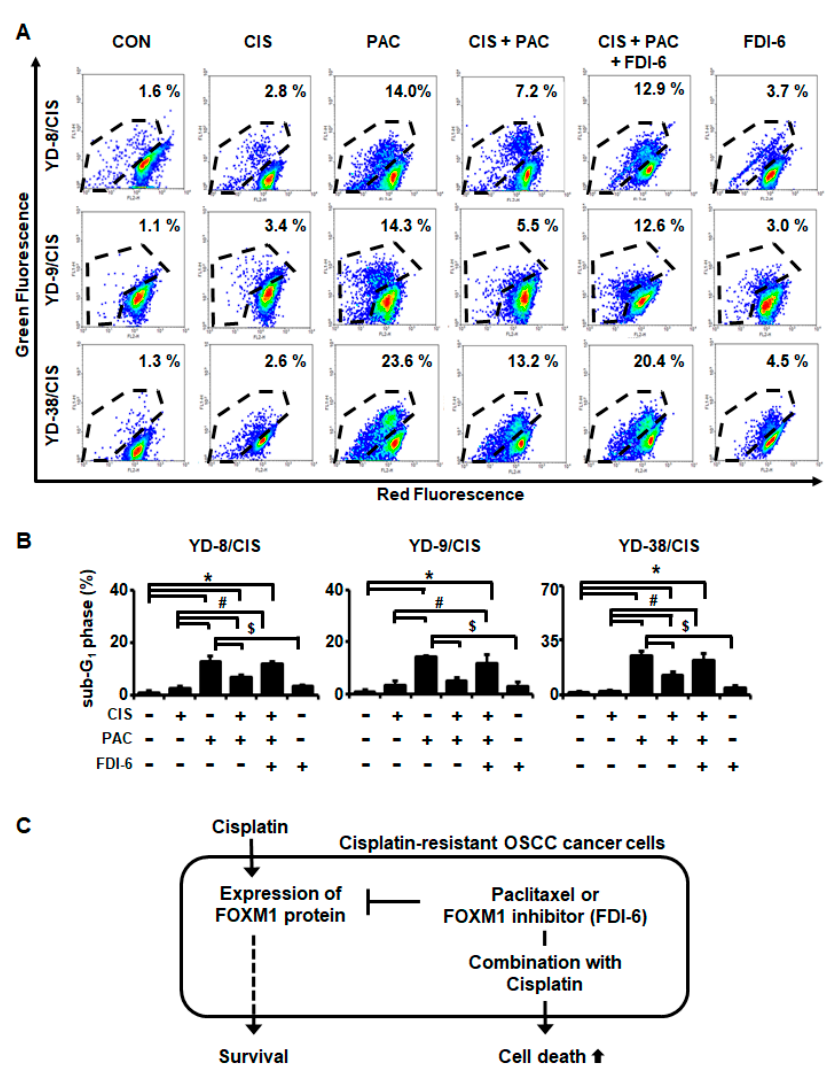
Figure 4. Treatment with FDI-6 in combination with cisplatin (10 µ g / mL) and paclitaxel (0.10 µ g / mL) for 24 h enhances apoptosis in cisplatin-resistant cell lines. ( A ) The fragmented DNA of apoptotic cells by each drug or combination treatment in cisplatin-resistant cell lines for 24 h was measured by a TUNEL assay. DNA strand breaks were measured by dual staining with rTdT enzyme (green fluorescence) and PI (red fluorescence). Data represent quantitative results for cells positive for rTdT enzyme in panel A of this figure. ( B ) Data represent quantitative results for panel A (mean ± SD; n = 3). * p < 0.05 versus non-treated group, # p < 0.05 versus only cisplatin-treated cells, and $ p < 0.05 versus only paclitaxel-treated cells. ( C ) Schematic diagram showing that cisplatin reduces paclitaxel-mediated apoptosis by overexpressing FOXM1 protein in cisplatin-resistant OSCC cancer cell lines.